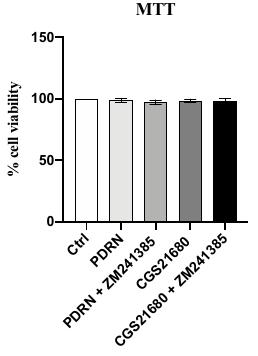
Figure 1. The graph shows cytotoxicity in 3T3-L1 cells by MTT assay following 24 h of treatment means and SD; n = 3 experiments.